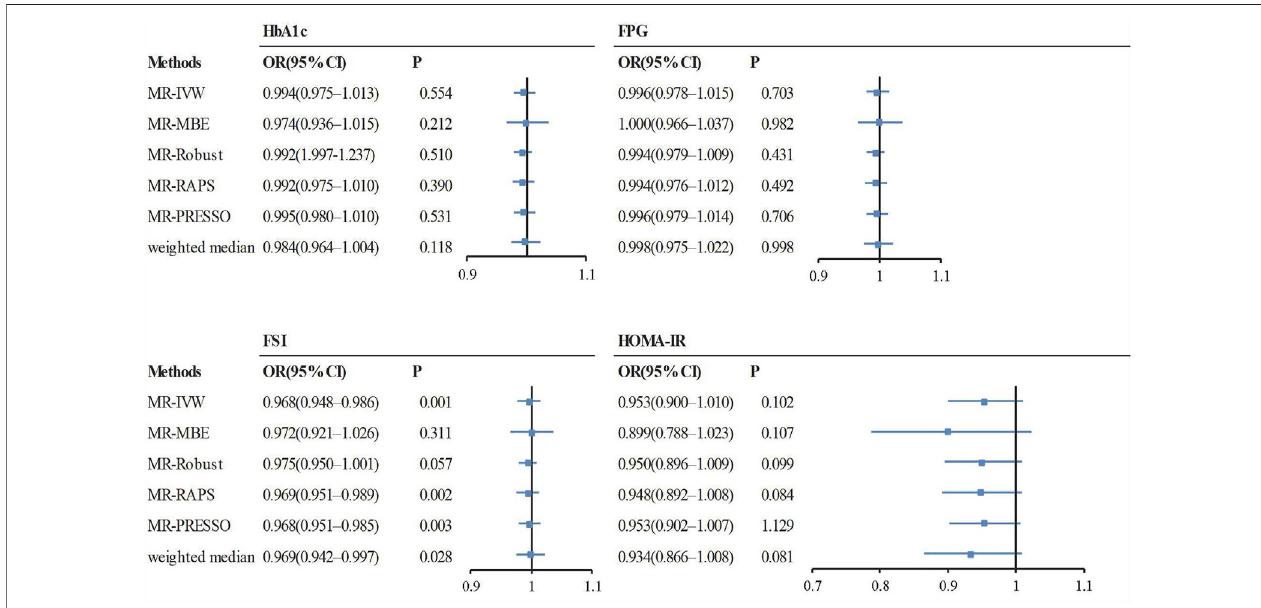
FIGURE6| The causal effect estimates from various MRmethods.The oddsratios oftea intake on glycemic traits are displayed asablack solidbox. The 95%CIs are shown as horizontal gray lines. Abbreviations: FPG, fasting plasma glucose; HbA1c, hemoglobin A1c; FSI, fasting serum insulin; HOMA-IR, homeostasis model of insulin resistance; MR, Mendelian randomization; MR-MBE, MR Mode-based estimate; MR-Robust, inverse variance-weighted method using robust regression; MR- RAPS, Robust Adjusted Pro fi le Score; MR-PRESSO, Mendelian Randomization Pleiotropy RESidual Sum and Outlier; OR, odds ratio.